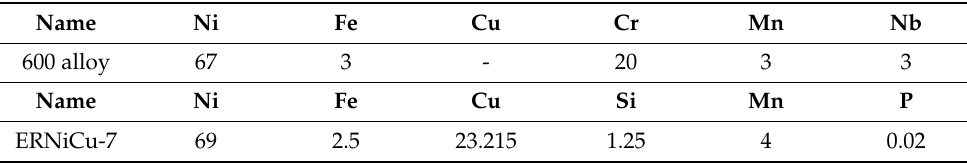
Table 2. Chemical compositions of the filler metals (wt.%).